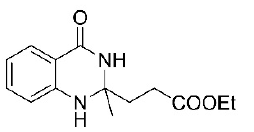
Figure S2: Effect of the catalyst amount on the reaction of anthranilamide ( 1 ) with ethyl levulinate ( 2 ) in the batch system; 1 H and 13 C NMR spectra of the isolated products; Chromatograms and mass spectra of the